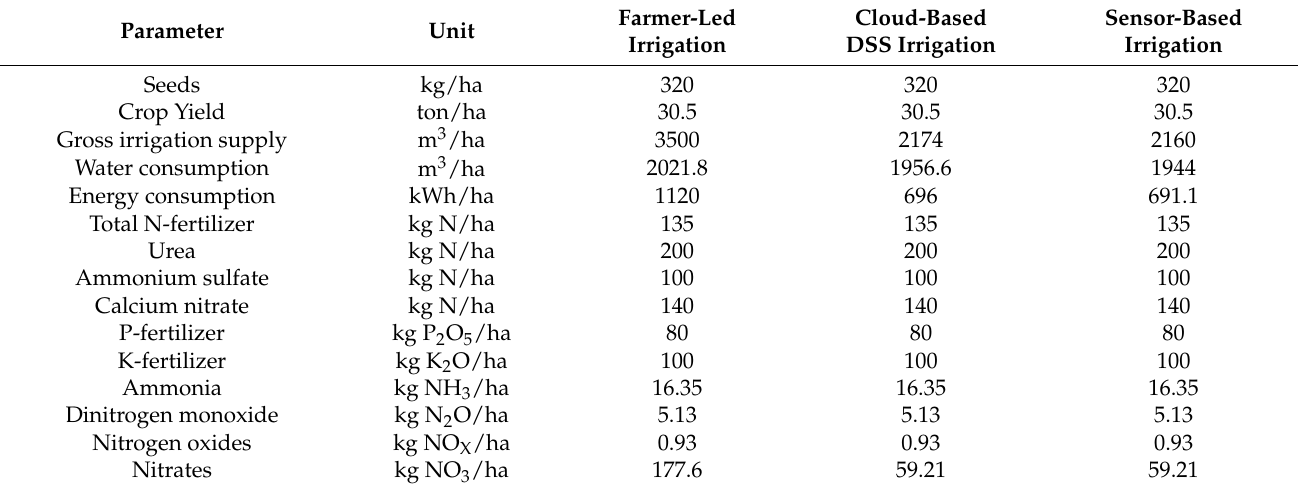
Table 3. Input-output data for 1 ha of zucchini greenhouse production.